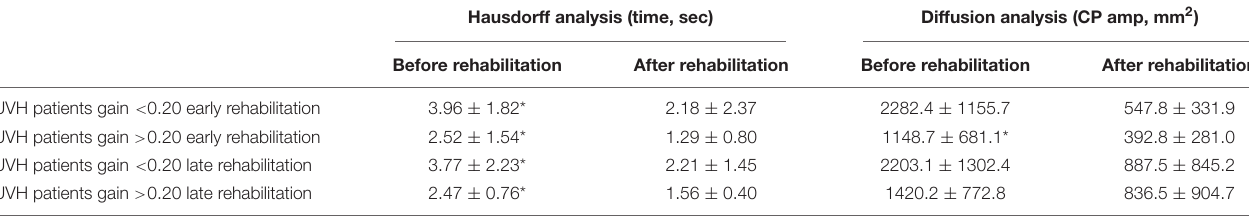
FIGURE 4 | (A,B) Effect of both early rehabilitation and degree of pre-rehabilitation vestibular hypofunction on dynamic balance recovery in the patients with UVH; energy cost. Comparison of the recovery profiles in the four sub-groups of patients with UVH tested in dynamic posturography (unstable platform) with eyes closed. Mean spectral power density (SPD, ± SD, in decimal Log) calculated with the wavelet analysis is shown for both sub-groups with higher (A) and lower (B) pre-rehabilitation degree of vestibular hypofunction. SPD scores recorded before rehabilitation (filled histograms) and after rehabilitation (open histograms) are shown for both sub-groups with early and late vestibular rehabilitation. Better recovery depends on both early rehabilitation and the degree of vestibular hypofunction. Significant differences are indicated by asterisks. ∗ p < 0.05; ∗∗ p < 0.01. TABLE 3 | Effect of vestibular rehabilitation on patients’ balance recovery in dynamic posturography